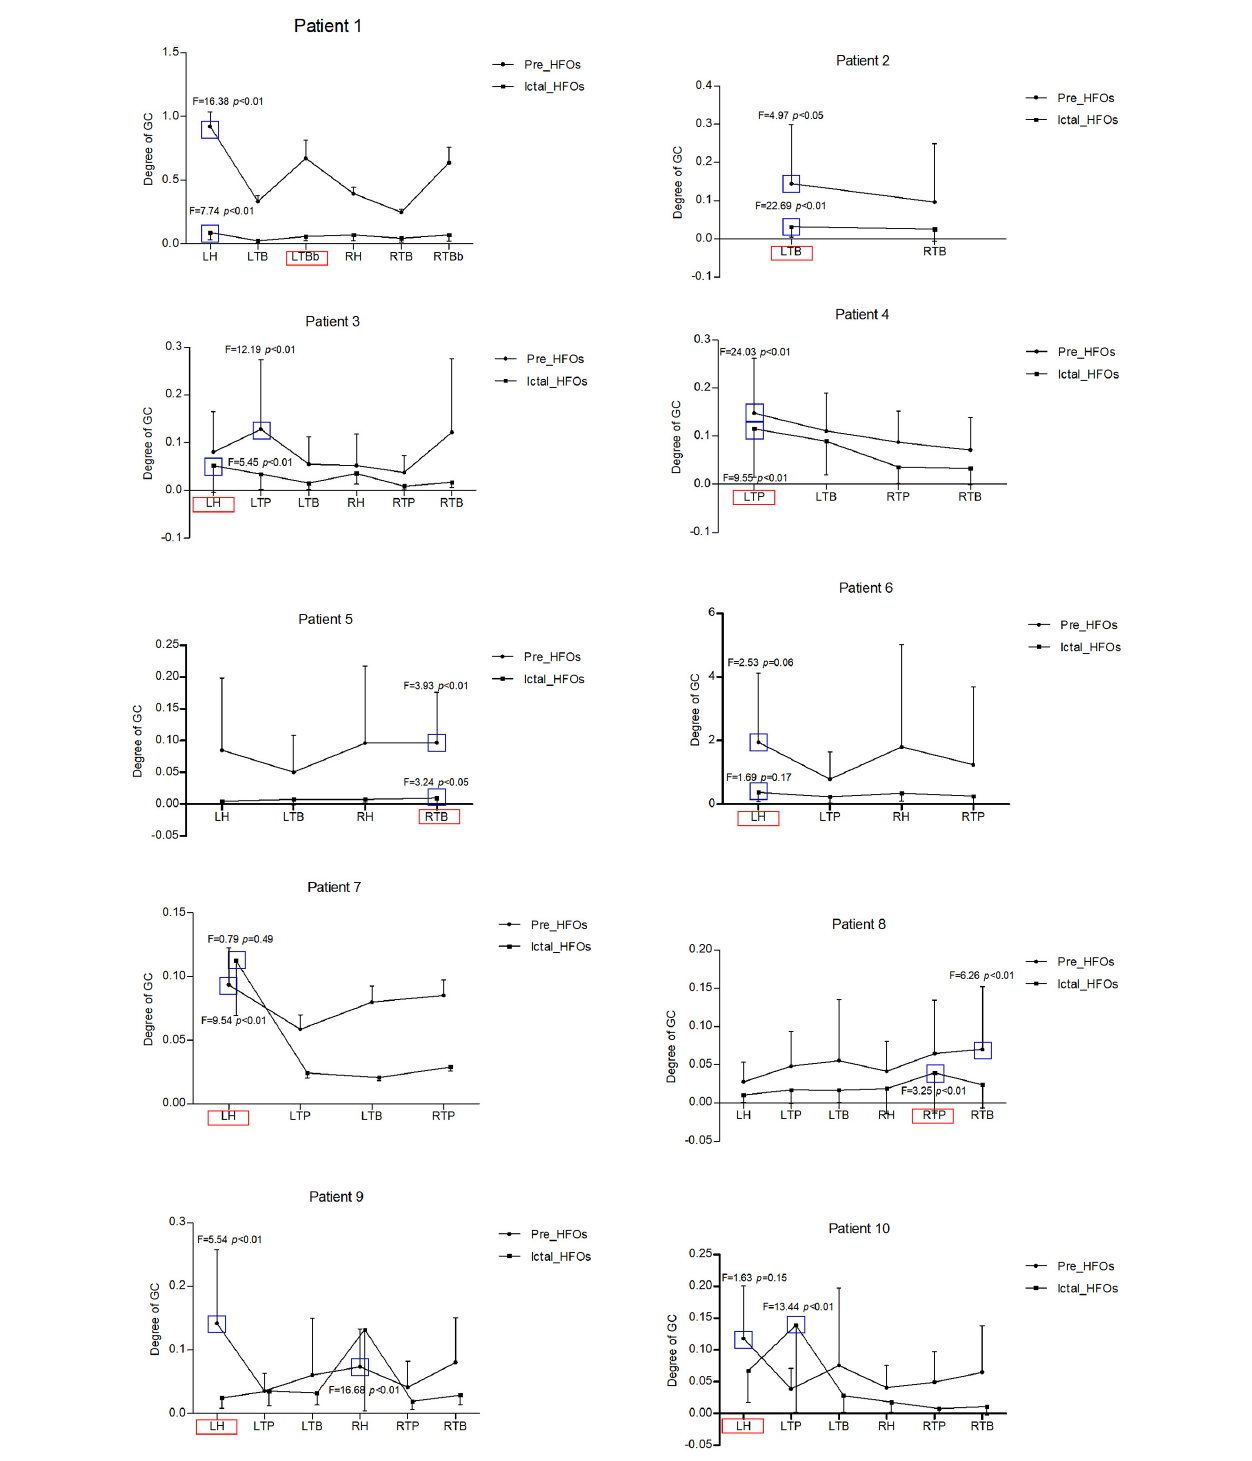
FIGURE 2 | These are all representing results in 10 patients regarding the GC analysis. X-axis is the different brain regions, Y-axis is the degree of GC, the bold circle shows the GC of pre-HFOs, the black square shows the GC of ictal HFOs. The red pane represents the ictal onset region with high-frequency oscillations (HFOs), the blue pane represents the highest GC with ictal onset region among all brain regions with HFOs either in pre-ictal or in ictal state. LH, left hippocampus; LTP, left temporal polar; LTB, left temporal-basal region; LTBb, left bottom of temporal-basal region; RH, right hippocampus; RTP, right temporal polar; RTB, right temporal-basal region; RTBb, right bottom of temporal-basal